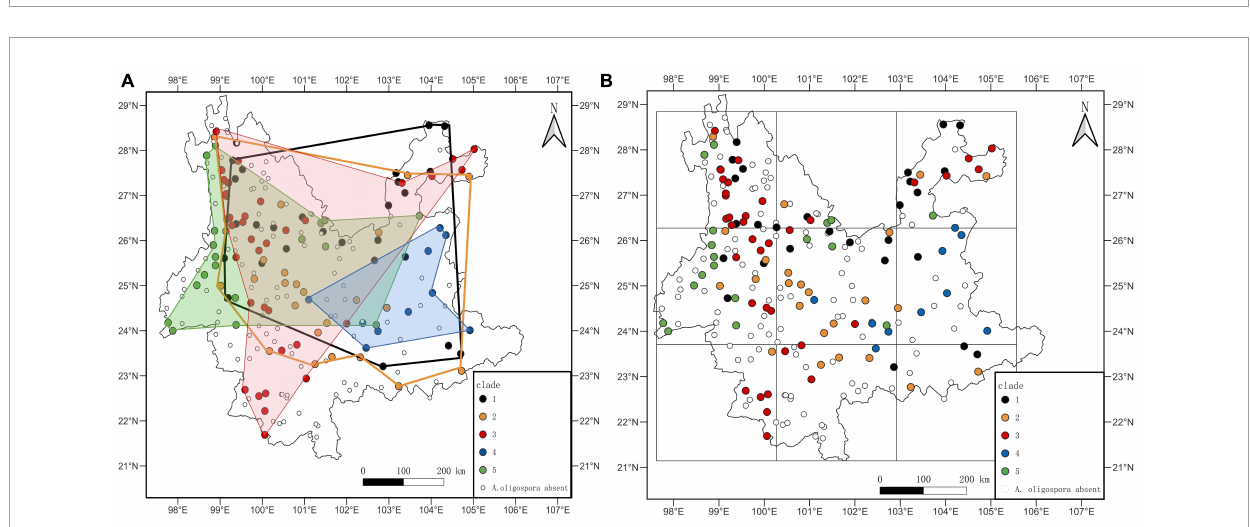
FIGURE5 Map of the biogeographical distribution of A. oligospora ; (A) is the map without the study unit, directly linking the individual Clade distribution boundaries; (B) is the map when the study unit is a